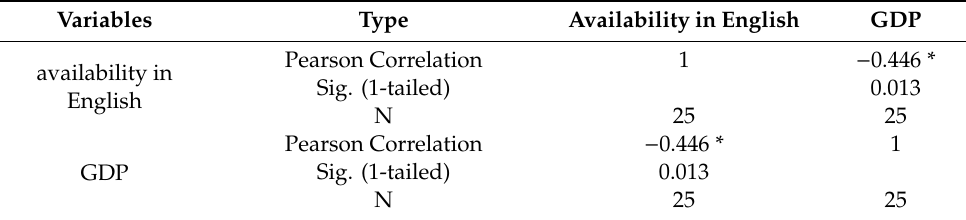
Table 6. Pearson correlation coe ffi cient between the Availability in English and GDP.